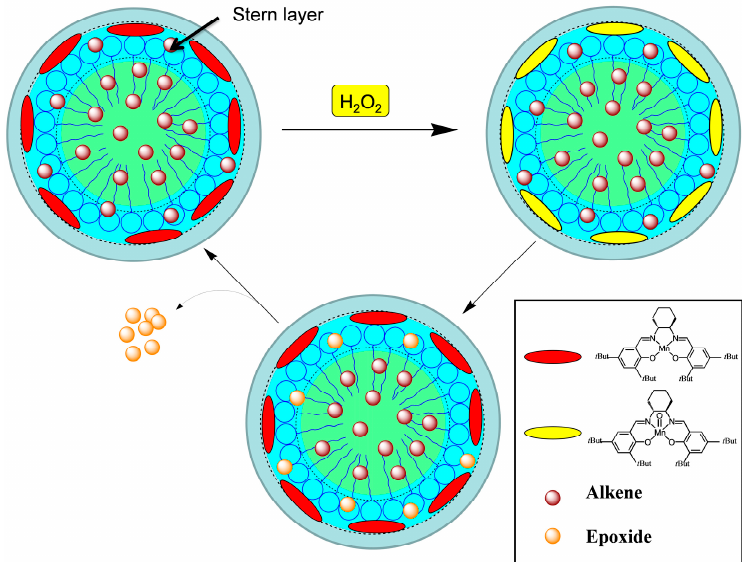
Figure 2. Schematic representation of the catalytic cycle.